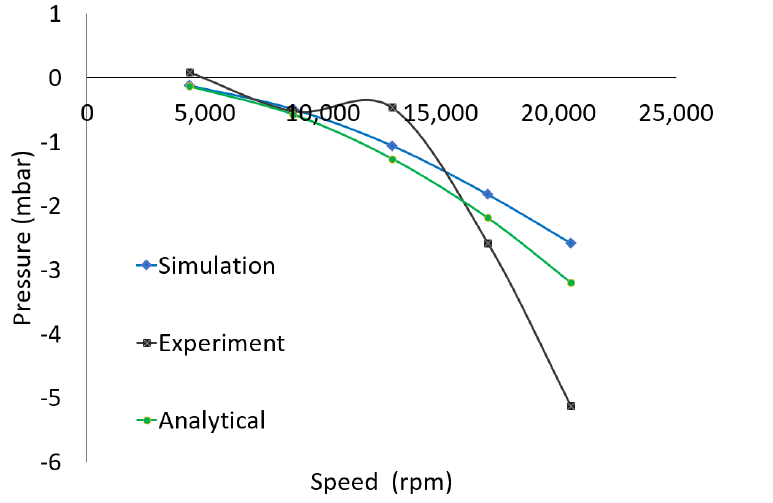
Figure 16. Pressure variation for 3 cm opening of the suction chamber.